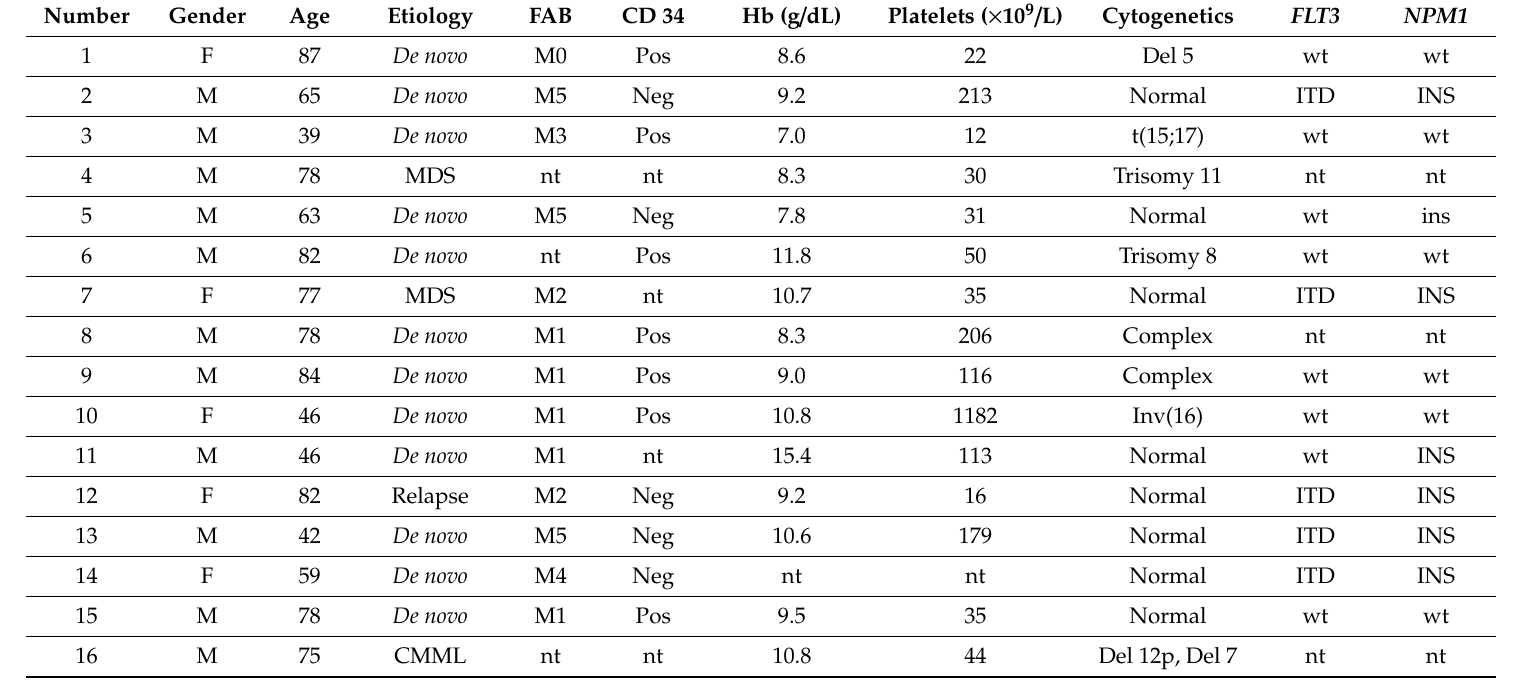
Table 1. Patient overview. Biological and demographical characteristics of the 16 patients included in the